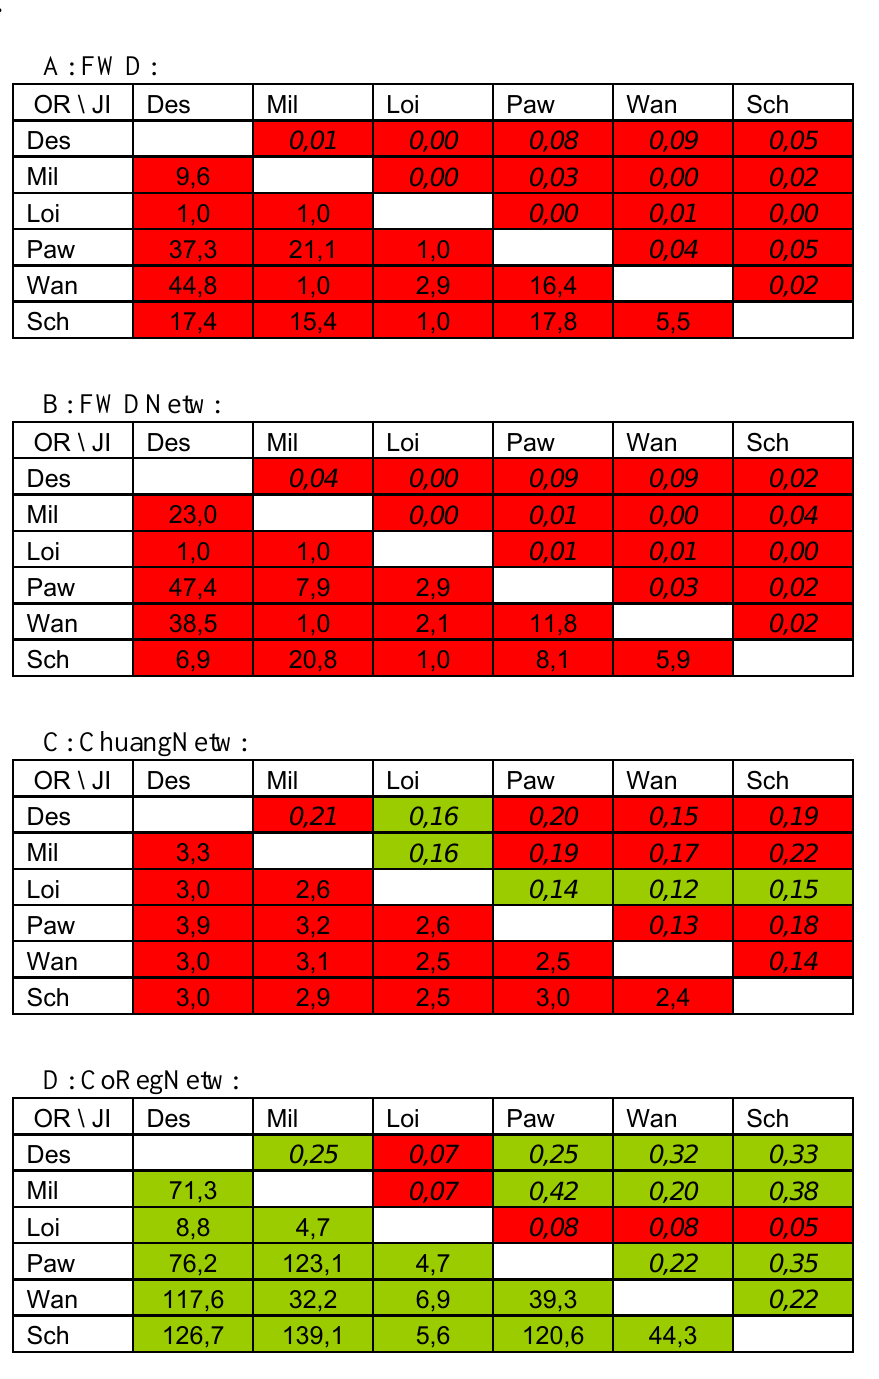
Table 3: Gene set similarities calculated between gene sets obtained from significant gene lists (FWD and FWDNetw) or significant sub networks (the method of Chuang et al. ChuangNetw and the method proposed in this paper CoRegNetw) within each single study. Shown similarity measures are the Jaccard index (above diagonal, italic) or odds ratio (below diagonal, not italic) grouped per method (Panels A to D). Pair wise comparisons depicted in green are outperforming all competing methods, the comparisons depicted in red are outperformed by at least one other